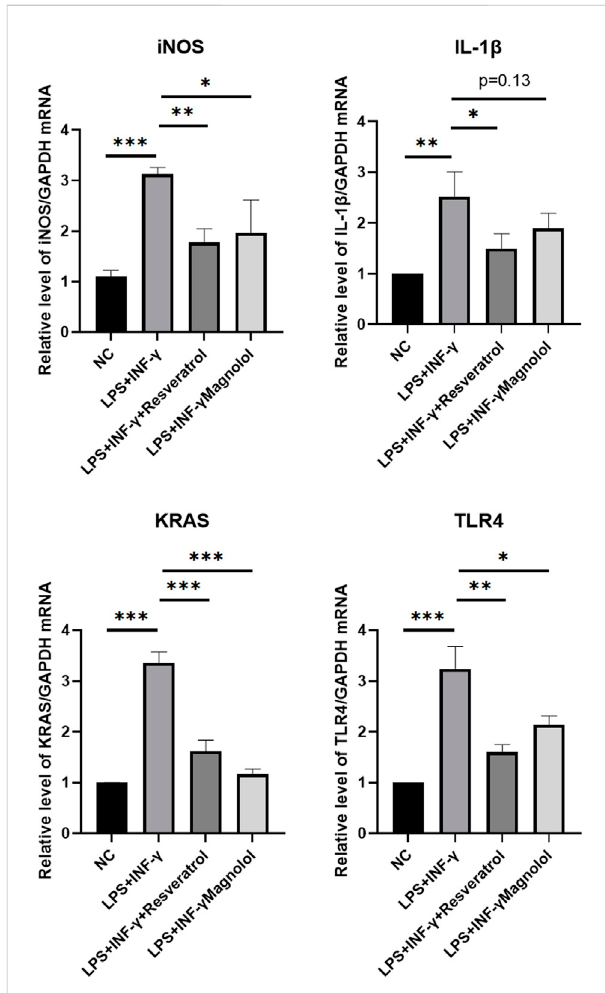
FIGURE 5 RT-QPCR results for validation over three independent experiments. Data are shown as mean ± standard error of the mean. * p < 0.05, ** p < 0.01, *** p < 0.001.